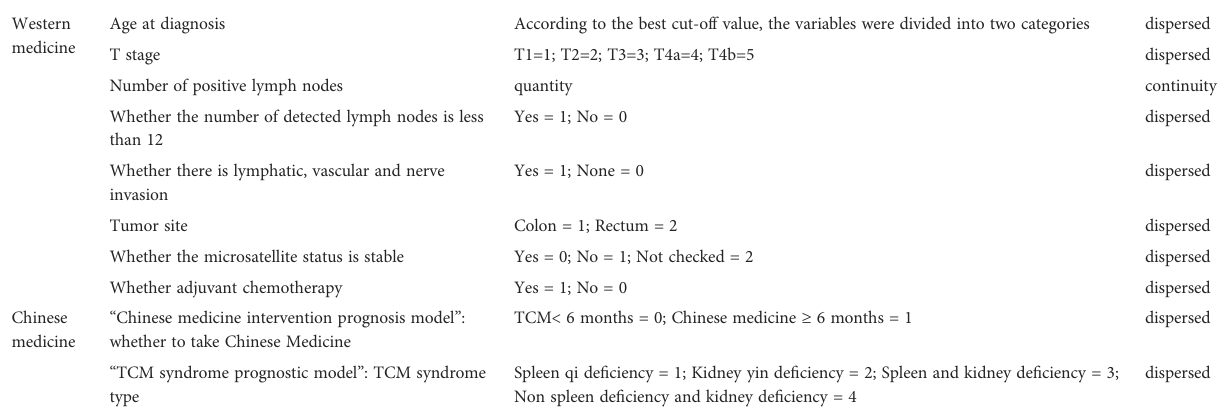
TABLE 1 Description of model